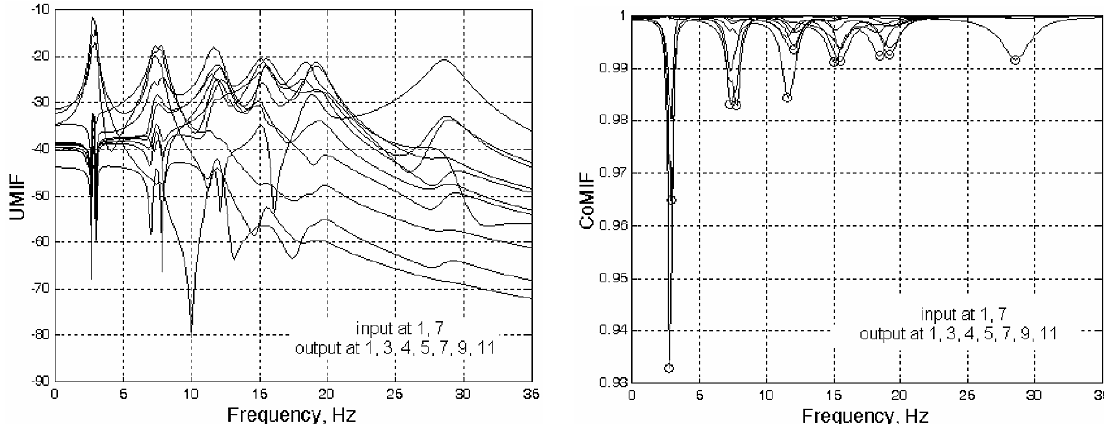
Fig. 16. UMIF for the 11-dof system. Fig. 17. CoMIF for the 11-dof